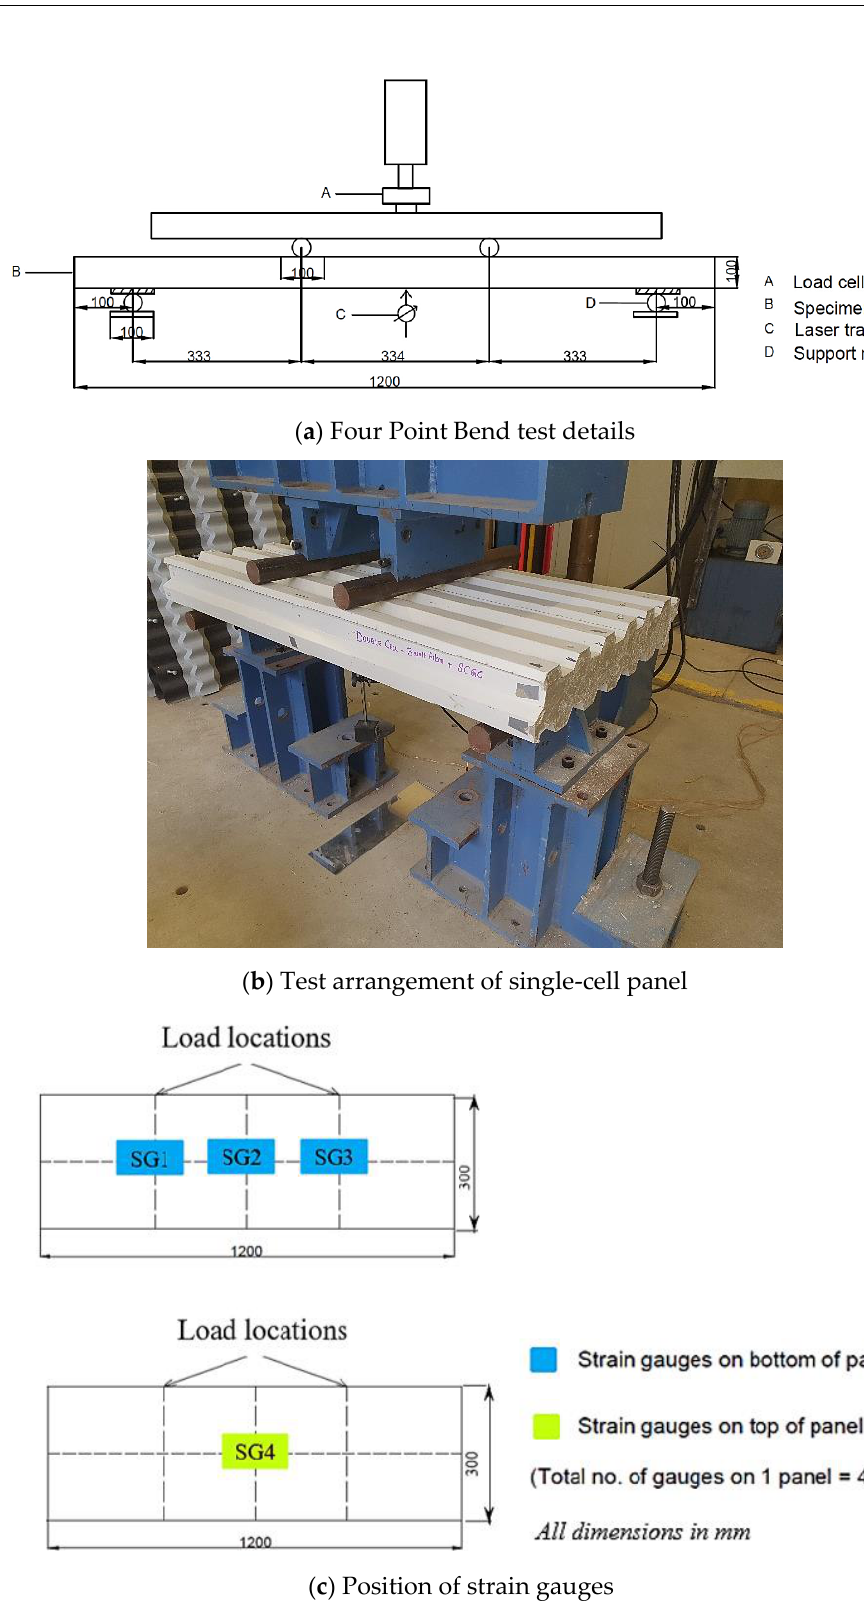
Figure 4. Test set-up details.